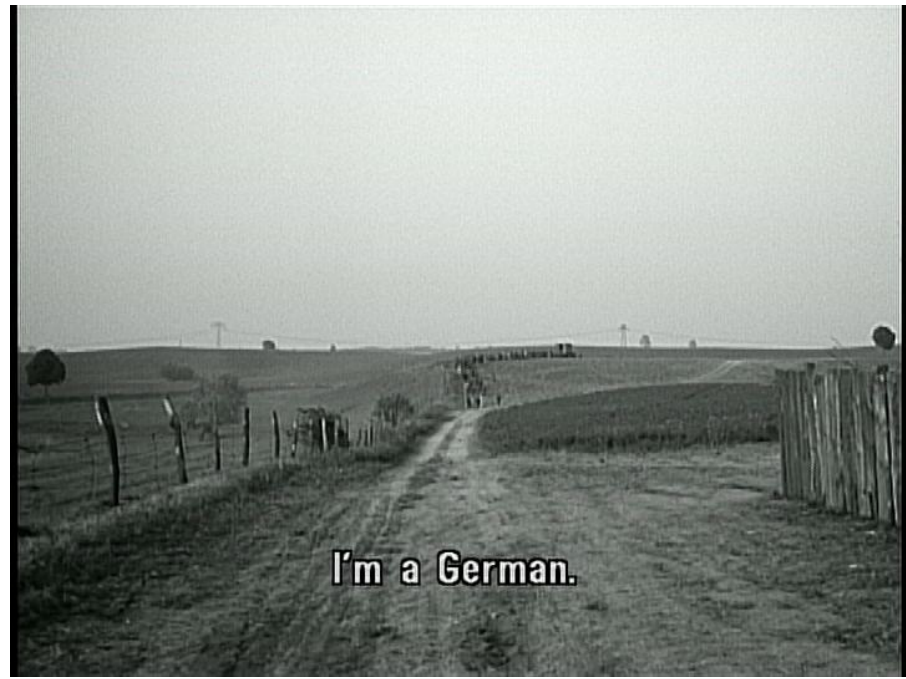
Figure 6. The defeated German soldiers marching away from the Heimat